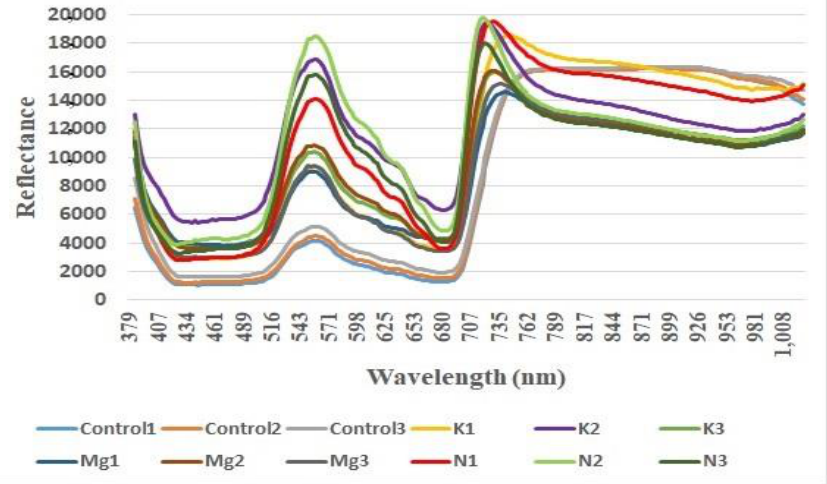
Figure 2. Reflectance vs. wavelength (nm) for three control, Potassium (K), Magnesium (Mg) and Nitrogen (N) leaves.